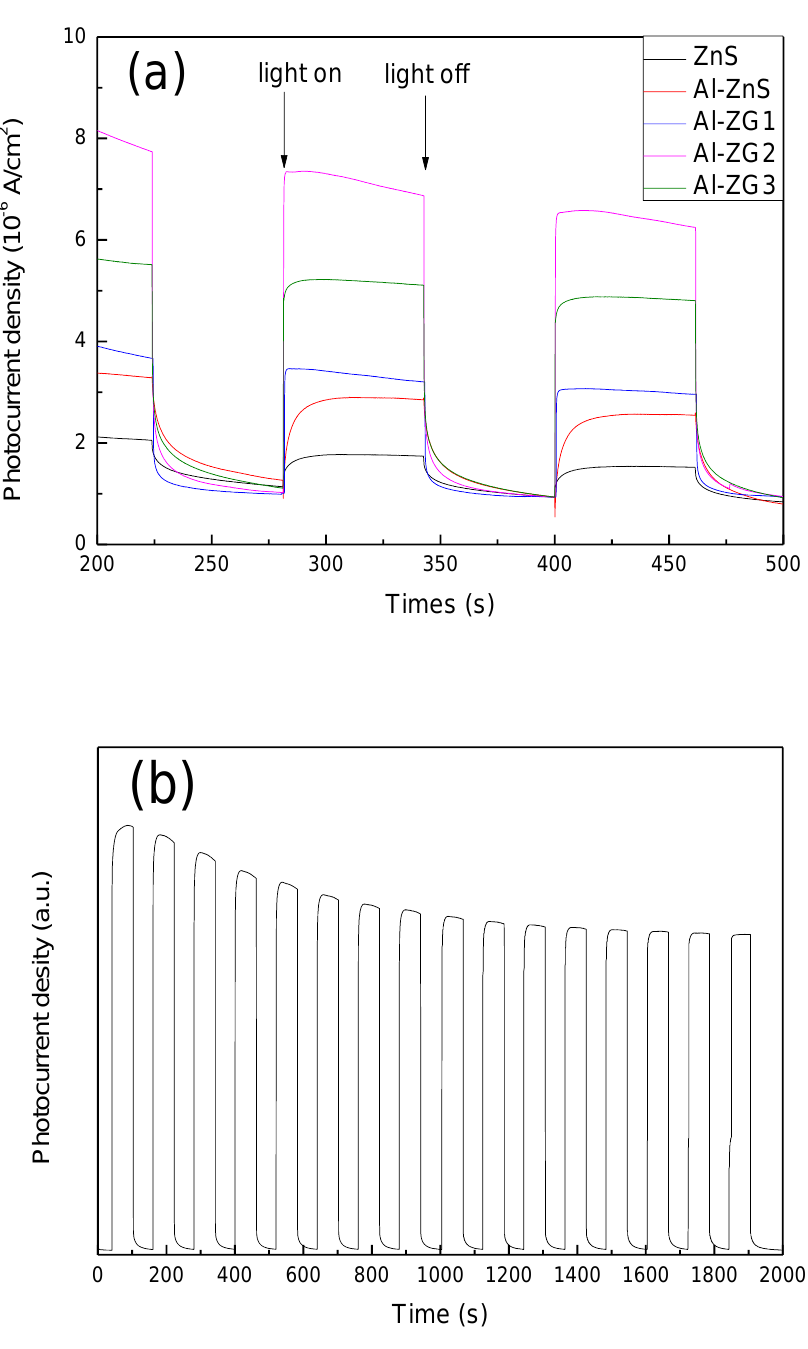
Figure 7. ( a ) Photocurrent-time test of ZnS, Al-ZnS, Al-ZG0.6, Al-ZG1.2 and Al-ZG1.8; ( b ) Photocurrent-time curve of Al-ZG composites in 2000 s.